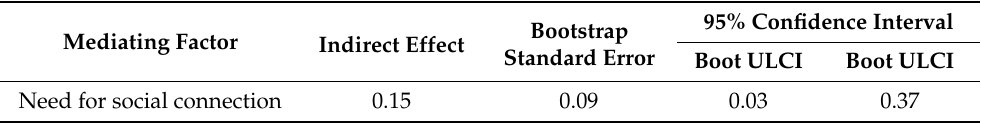
Table 2. Mediation Effect of the Need for Social Connection in the Relationship between the Experi- ence of Warmth and Intentions toward Prosocial